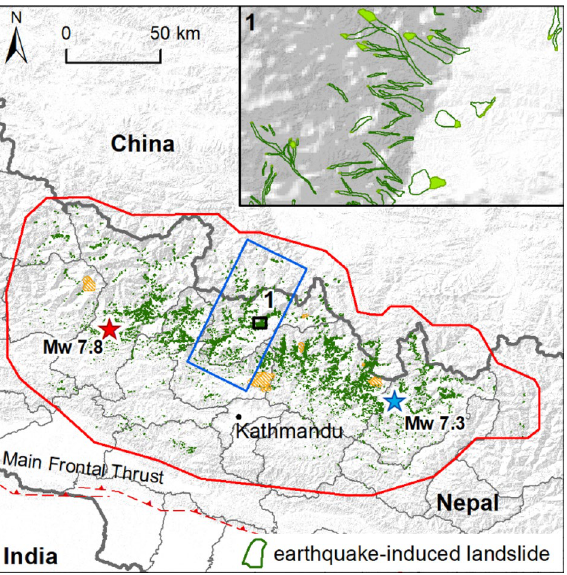
Figure 1. Earthquake-induced landslides inventory, with the 21,151 landslides mapped as a polygons. The bold grey line is the boundary of Nepal, while the thin grey lines are the district boundaries in Nepal. The blue rectangle identifies the area (2230 km 2 ) where the scar area was identified and mapped as an independent feature for 1500 out of 2258 landslides. The red and blue stars localize the main foreshock and the main aftershock, respectively. The inset 1 shows an example of landslides mapped as polygons in the inventory, with the distinction of scar (filled) and runout (outline) areas. The red line indicates the study area. Orange areas indicate unmapped areas due to clouds cover or low quality images. (The map was generated by using ArcGIS 10.3.1,